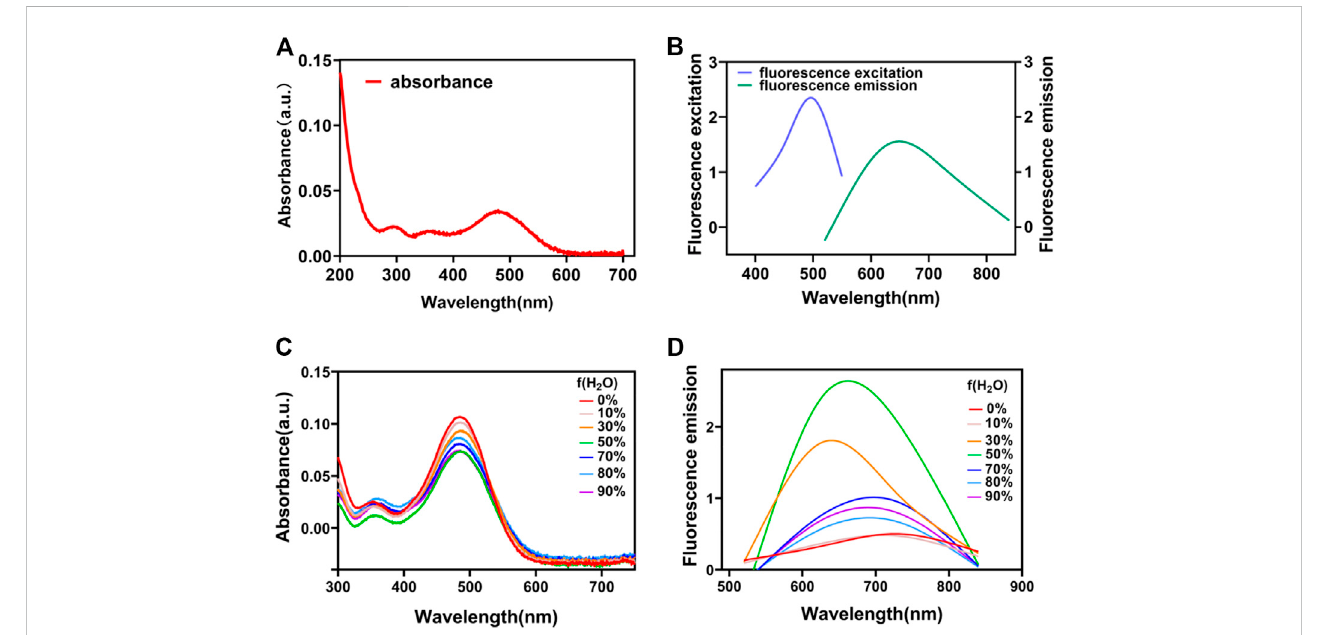
FIGURE 1 UV – visabsorption (A) and fl uorescencespectra (B) ofQSN.UV – visabsorption (C) and fl uorescencespectra (D) ofQSNinthemixedsolventwithvarious DMSO/H 2 O